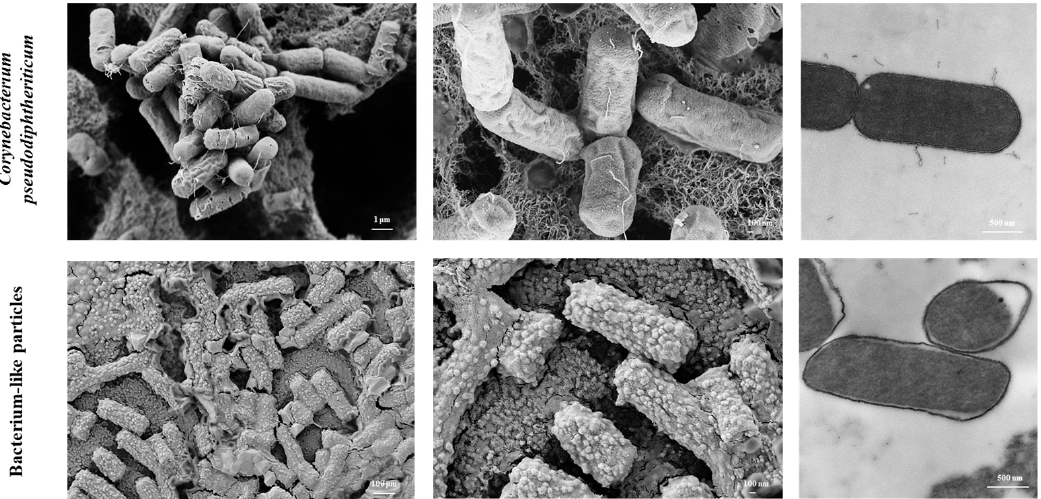
Figure 1. Scanning (SEM) and transmission (TEM) electron microscopy analysis. Corynebacterium pseudodiphtheriticum 090104 untreated cells and bacterium-like particles (BLPs) obtained from the 090104 strain by heat–acid treatment. Ultrathin sections cuts were examined with a Zeiss libra 120 and a Supra55VP microscopes for TEM and SEM, respectively.